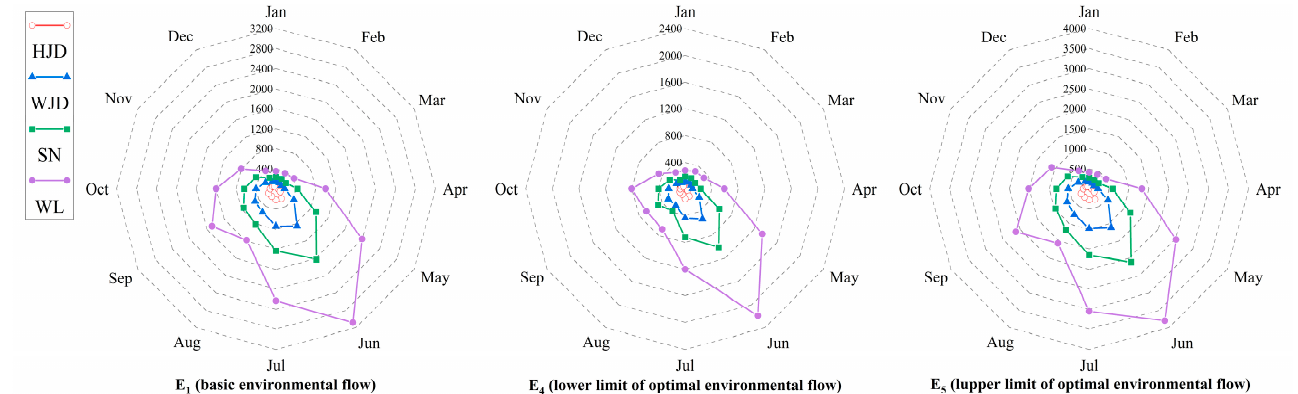
Figure 4. Environmental flow processes of each